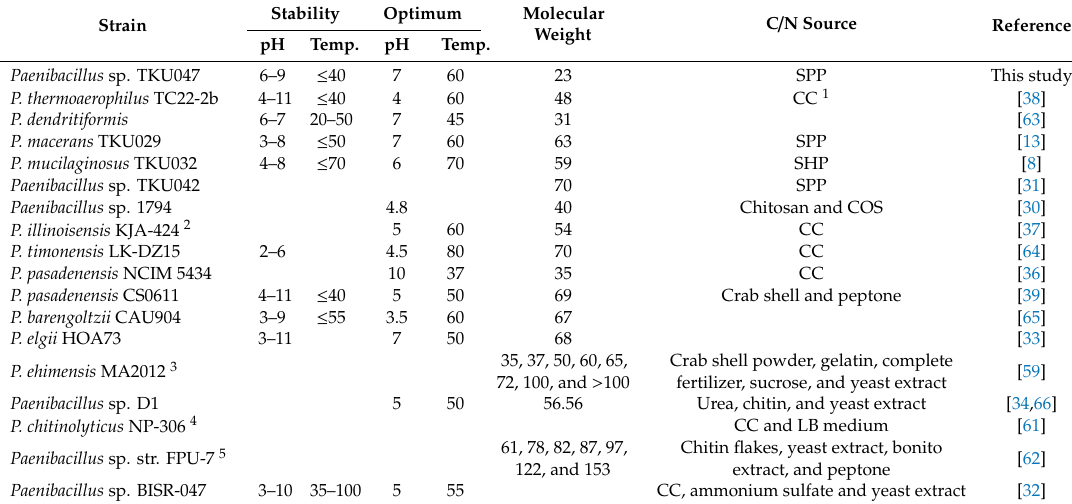
Table 2. Comparison of chitinase/chitosanase produced by Paenibacillus strains.